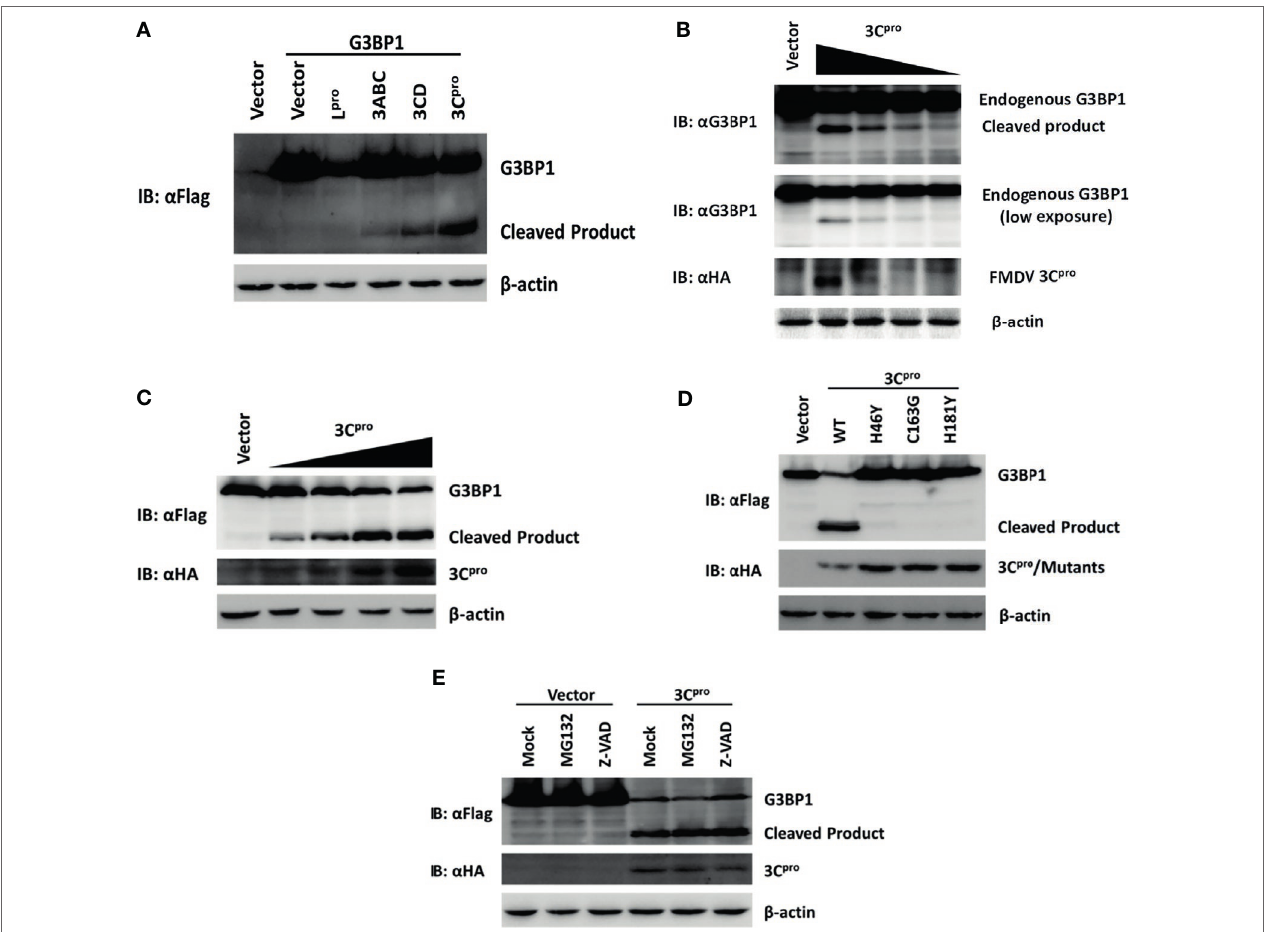
FigUre 6 | Foot-and-mouth disease virus 3C pro cleaves G3BP1 by means of its protease activity. (a) Human embryonic kidney cells (HEK)-293T cells cultured in 60-mm dishes were transfected with Flag-tagged porcine G3BP1 as indicated (4 µg), along with HA-L pro , 3C pro , or 3C pro -containing precursors (0.05 µg). Cell lysates were prepared 30 h post-transfection and analyzed by western blotting. (B) IBRS-2 cells were transfected with increasing quantities (0, 0.5, 1, 2, or 4 µg) of plasmid encoding 3C pro . Cell lysates were prepared 36 h post-transfection and analyzed by western blotting. (c) HEK-293T cells were transfected with Flag-tagged wild-type porcine G3BP1 (4 µg), along with increasing quantities HA-3C pro plasmid (0, 0.0125, 0.025, 0.05, or 0.1 µg). Cell lysates were prepared 30 h post-transfection and analyzed by western blotting. (D) HEK-293T cells were transfected with Flag-tagged porcine G3BP1 expression plasmid (4 µg), along with wild-type 3C pro expression plasmids or its mutants (0.05 µg). Cell lysates were prepared 30 h post-transfection and analyzed by western blotting. (e) HEK-293T cells were co-transfected with Flag-tagged porcine G3BP1 expression plasmid (4 µg) and plasmid encoding 3C pro or empty vector (0.05 µg). 24 h after transfection, MG132 or zVAD-FMK were added to a final concentration of 20 µM. Cell lysates were prepared 8 h after treatment and analyzed by western